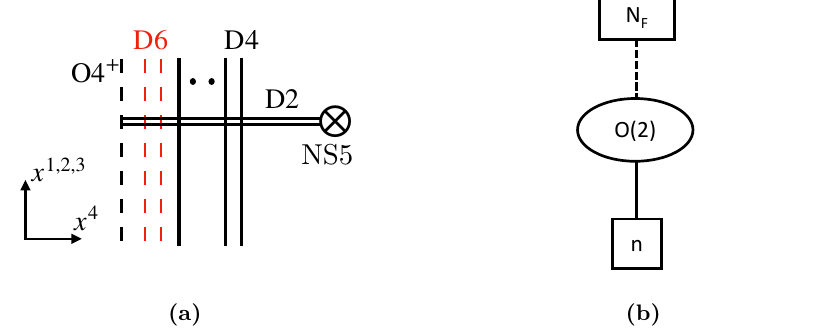
Figure 31. (a): the brane configuration for the monopole screening sector v = 0 of the ’t Hooft operator T . (b): the corresponding SQM quiver, which computes Z 00 ∧ 2 V